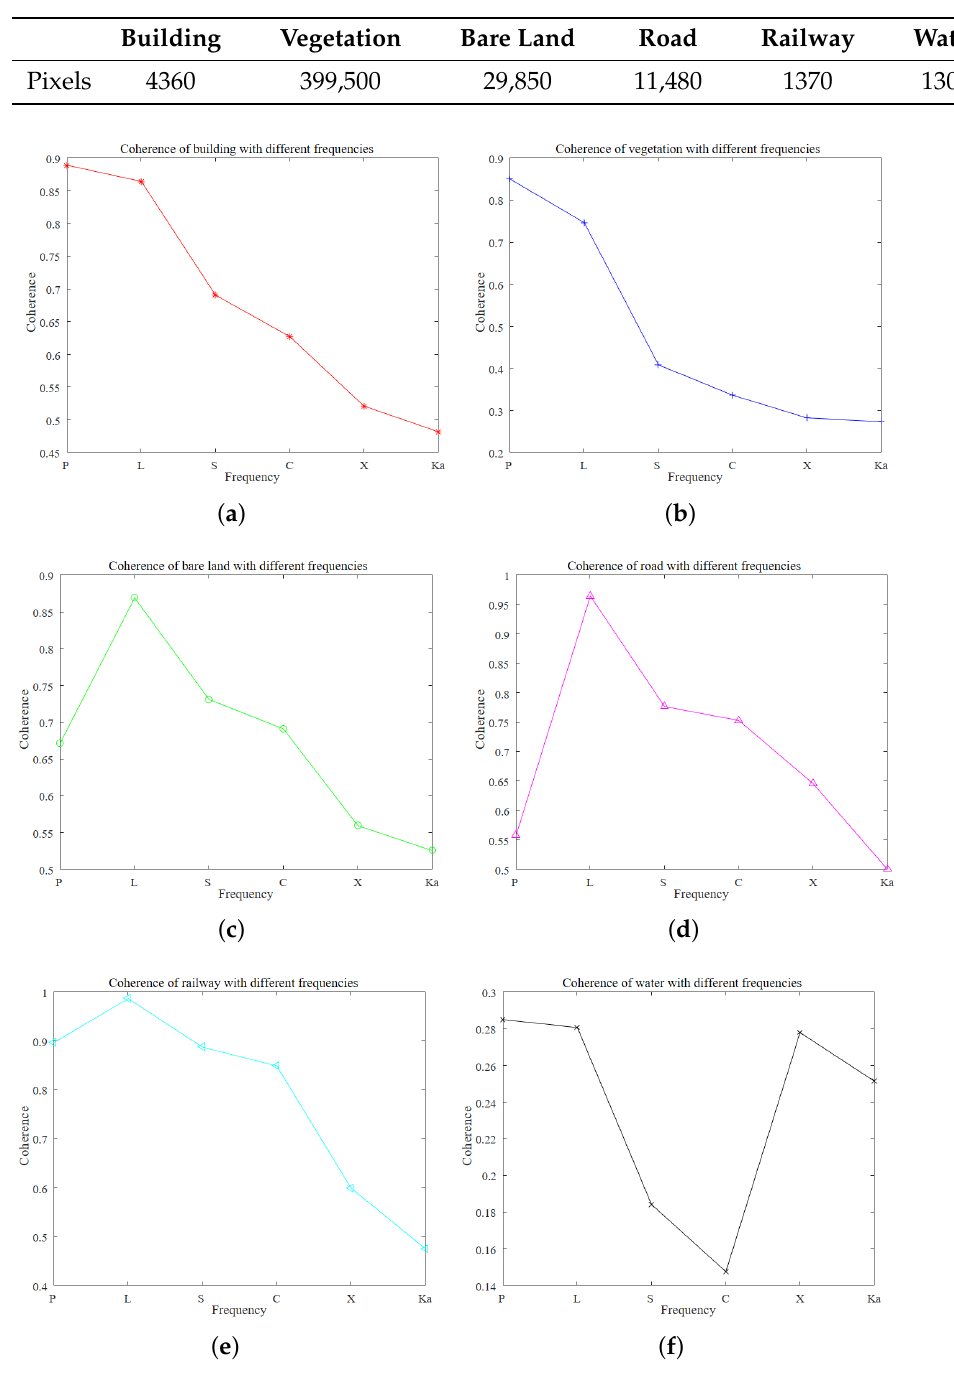
Figure 5. Coherence statistics of typical objects. ( a ) Building region. ( b ) Vegetation region. ( c ) Bare land region. ( d ) Road region. ( e ) Railway region. ( f ) Water